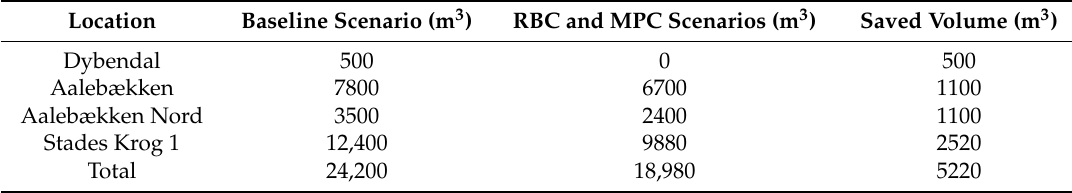
Table 1. Increased storage volumes for the simulated scenarios at relevant basin